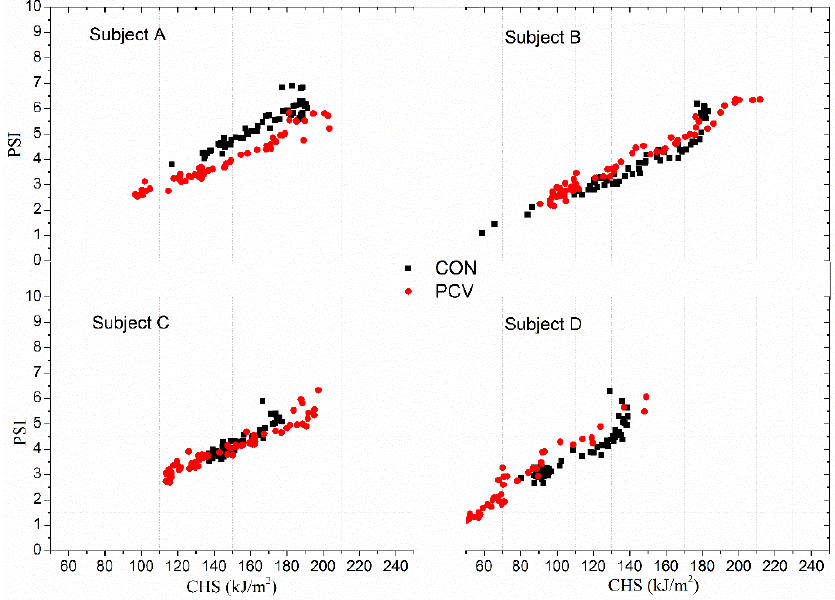
Figure 6. PSI versus CHS for subjects in CON and PCV.